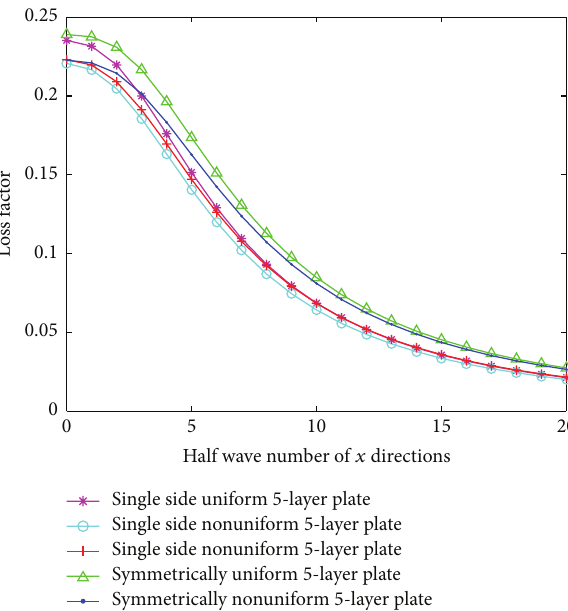
Figure 14: The loss factor of five-layered constrained damping plate with various